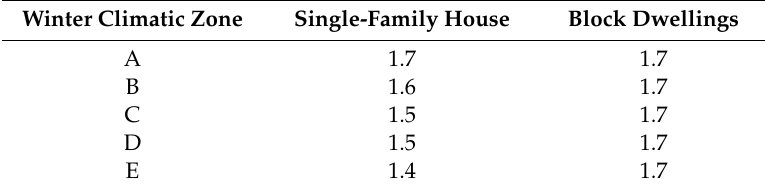
Table 3. Values for R in Equation (6)